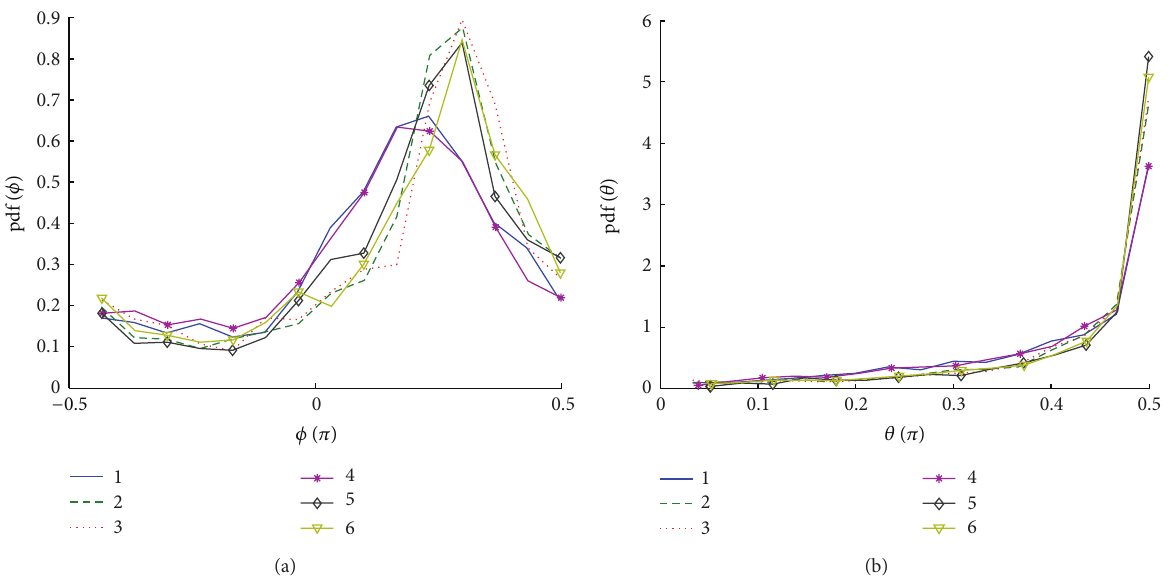
Figure 8: Orientation distribution at six positions: 1, 2, and 3 are at 𝑥 ∗ = 228 and correspond to 𝑐 = 0.3 , 𝑐 = 0.5 , and 𝑐 = 0.7 , respectively; 4, 5, and 6 are at 𝑥 ∗ = 319 and correspond to 𝑐 = 0.3 , 𝑐 = 0.5 , and 𝑐 = 0.7 , respectively. (a) Azimuthal angle 𝜙 ; (b) polar angle 𝜃